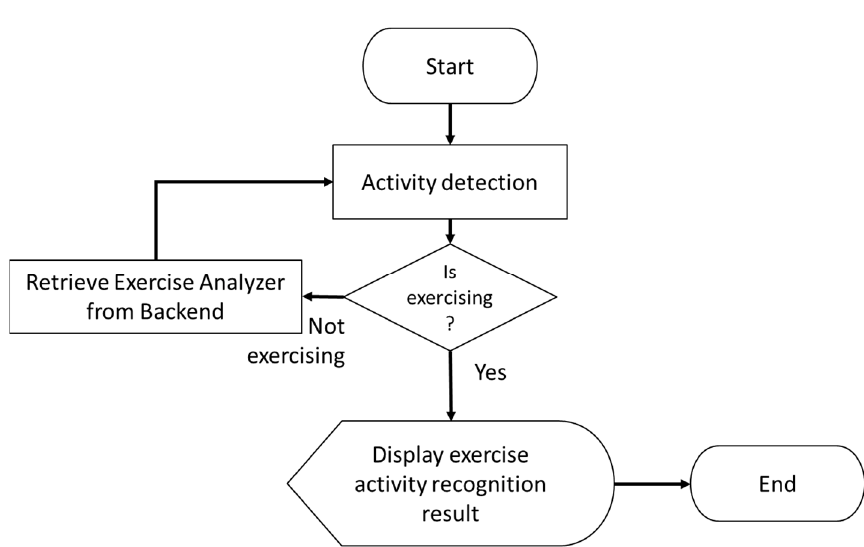
Figure 20. Flowchart for the Climbing Gym system.